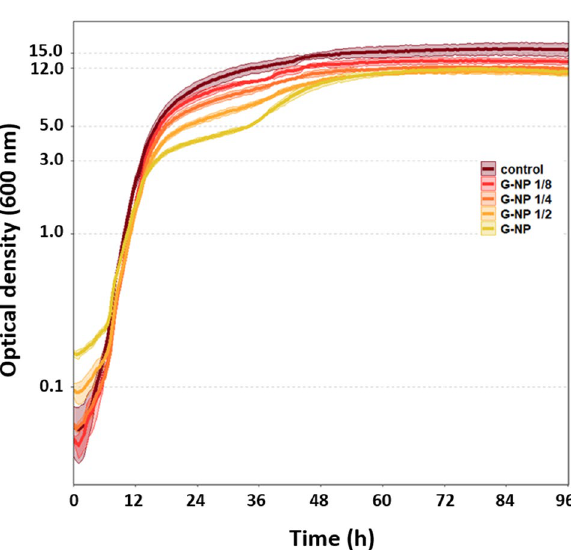
Figure 5. SEM images of Y. lipolytica cells ( a ) untreated, ( b ) treated with bare iron oxide nanoparticles, ( c ) treated with graphene-coated iron oxide nanoparticles. ( d ) Aggregation of Y. lipolytica cells on a glue-like matrix of extracted lipids.